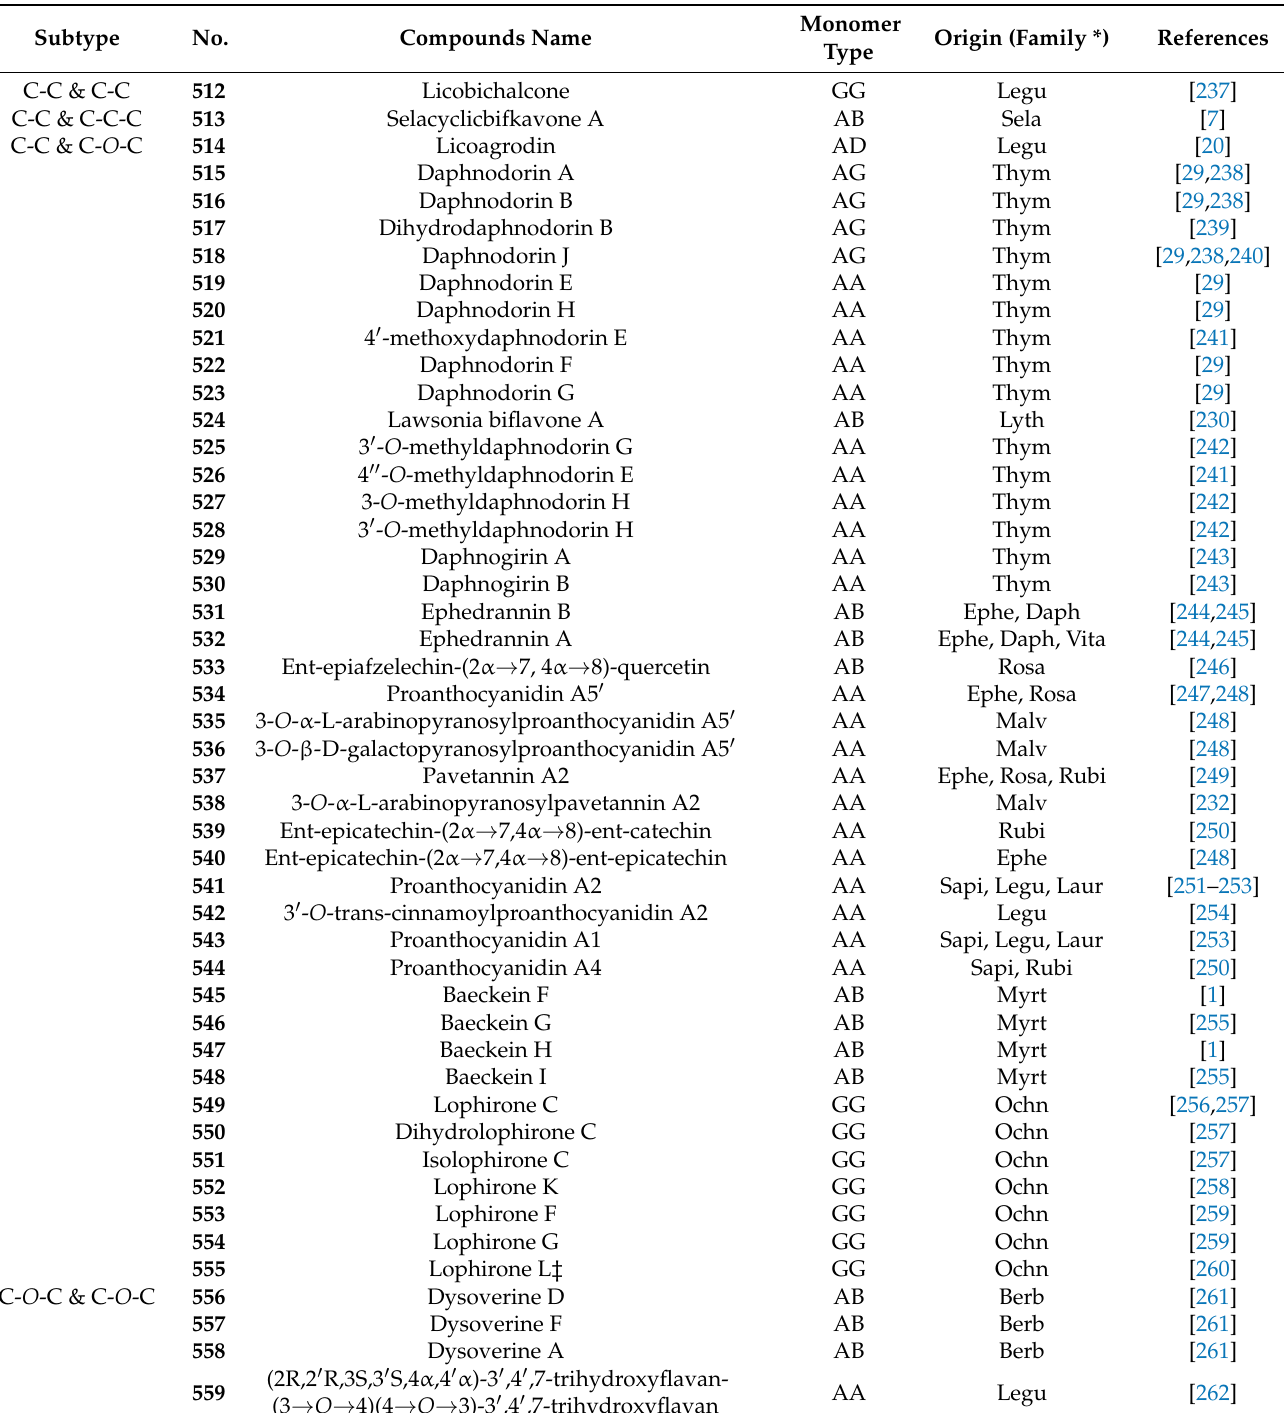
Table 10. Complex biflavonoids. (Simple-ring